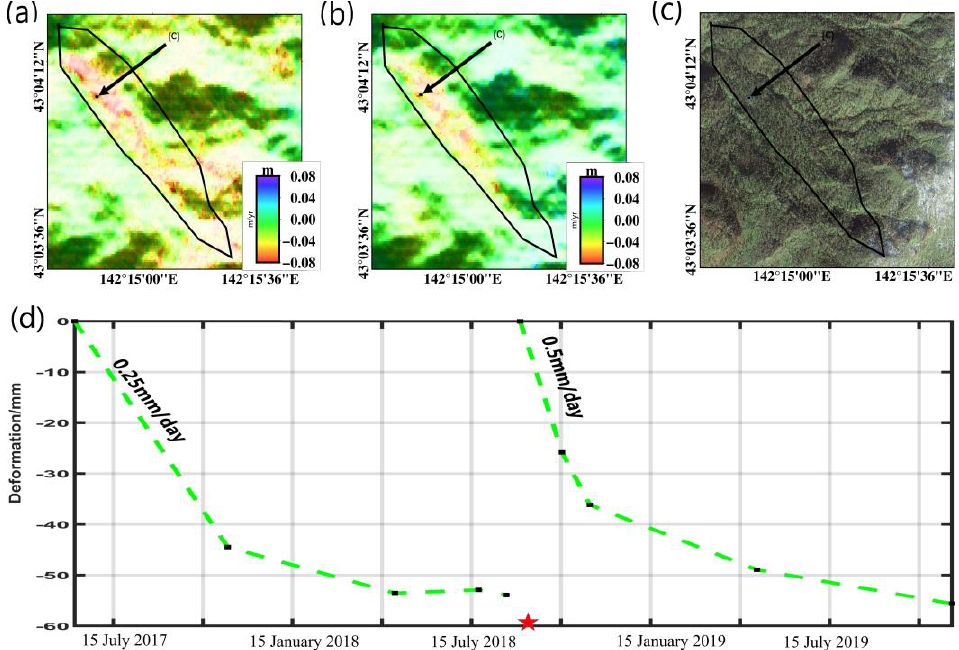
Figure 11. ( a , b ) Average LOS deformation velocities of landslide P1 before and after the earthquake, respectively. ( c ) Optical image of landslide P1. ( d ) Time series deformation of point C before and after the earthquake. The pentagram indicates the time of the earthquake.